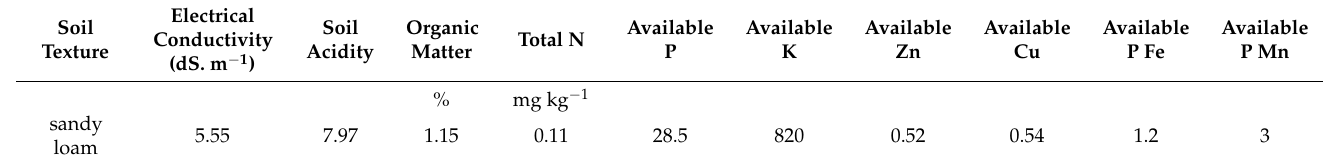
Table 1. Physicochemical properties of the